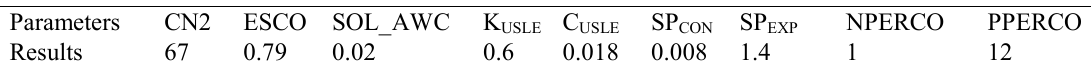
Table 2 The correction parameters threshold of SWAT